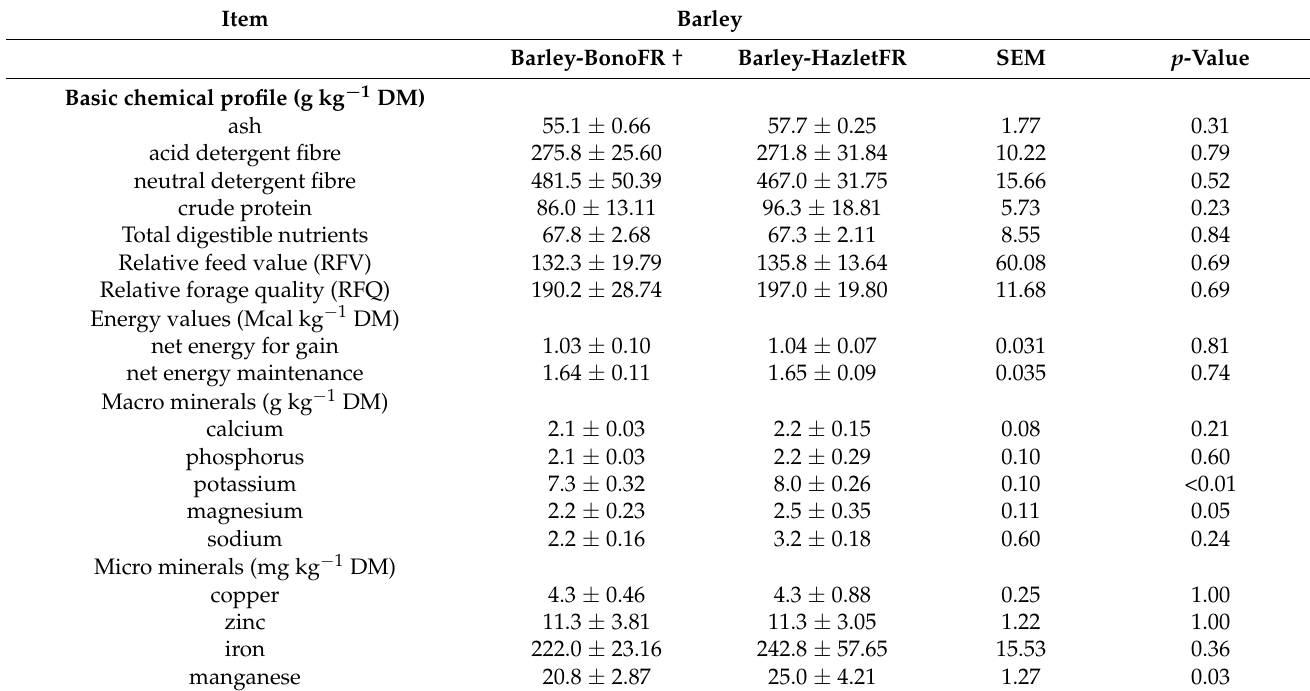
Table 4. Nutrient composition (means ± SD) of whole-crop barley in double cropping system with fall